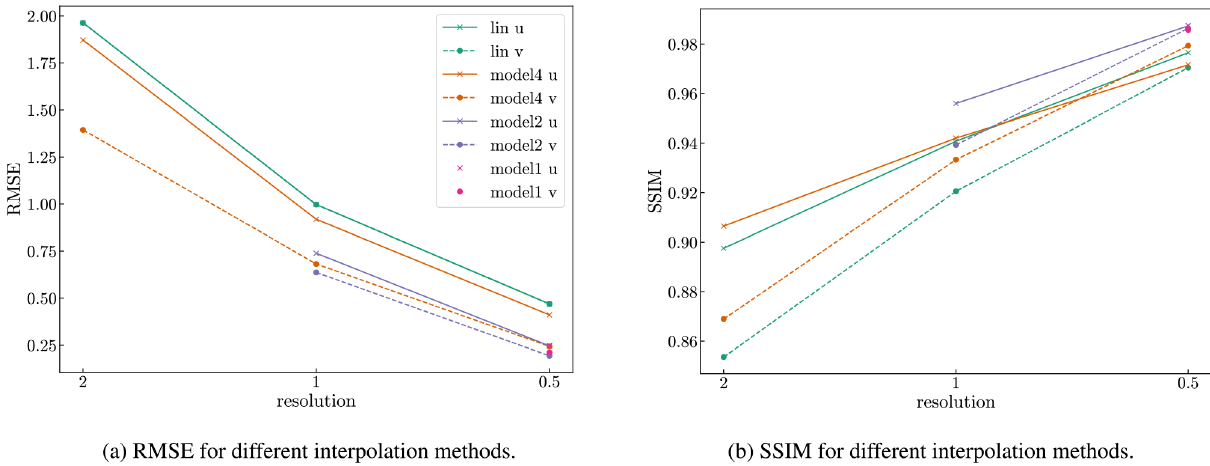
Figure 2. RMSE (a) and mean SSIM (b) of the validation data set (14 January 2000) for linear and neural network interpolation evaluated at different resolutions. Here, we do not interpolate the fields multiple times (as explained in Sect. 3.1.2) but rather once for each resolution starting from the resolution the model is trained on. The solid lines are computed for the u velocity and the dashed lines for the v velocity.